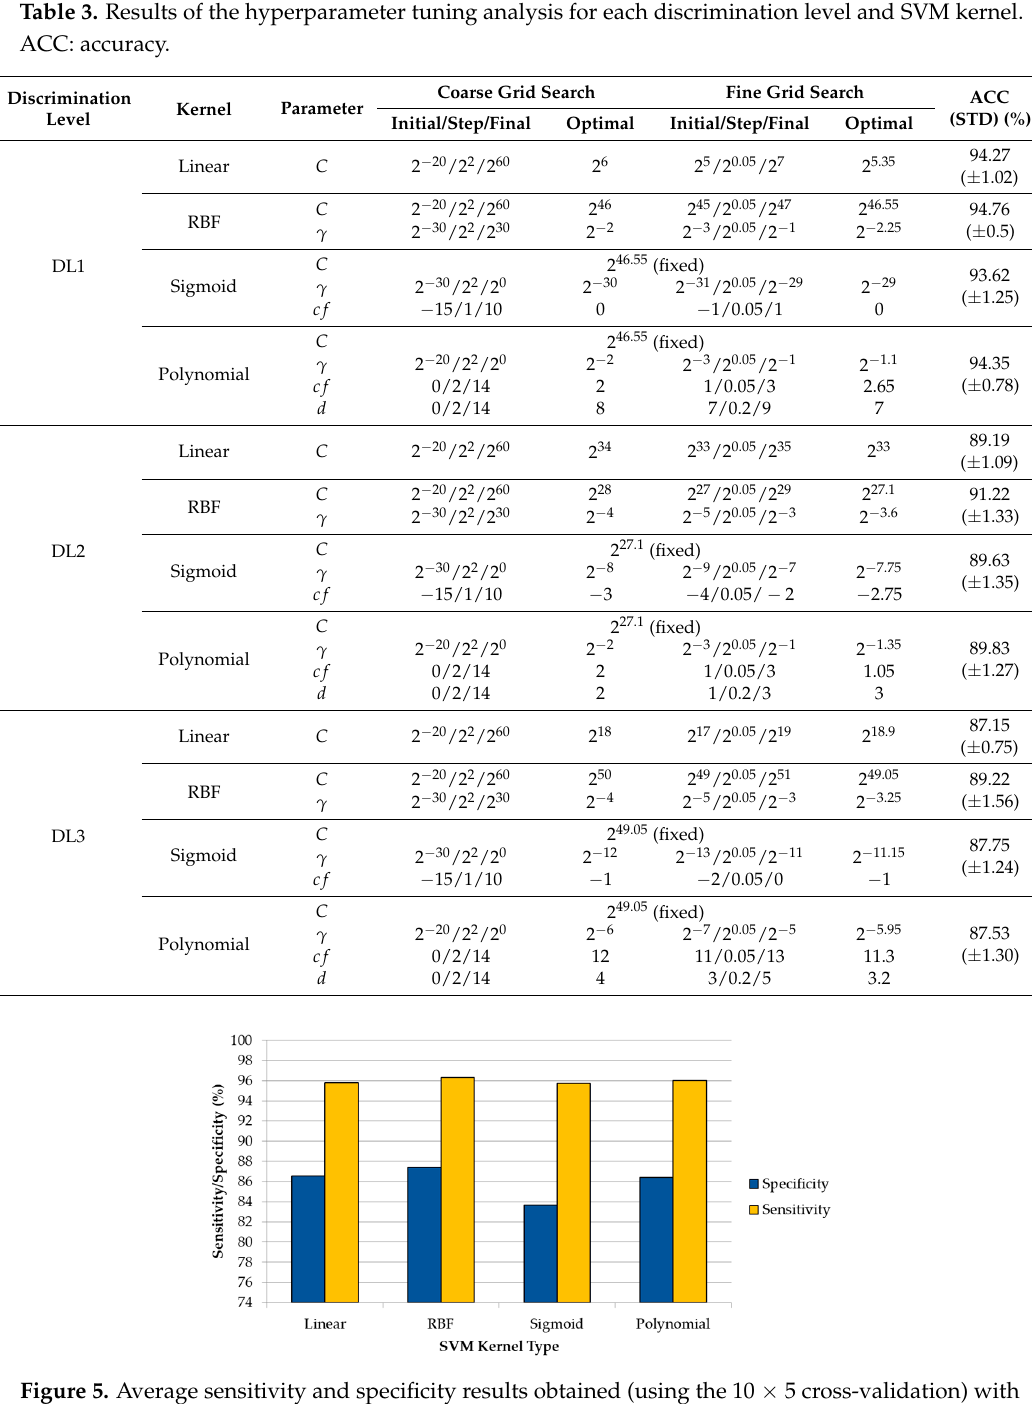
Figure 5. Average sensitivity and specificity results obtained (using the 10 × 5 cross-validation) with the optimal hyperparameters for each kernel type in the DL1 (tumor vs. normal).